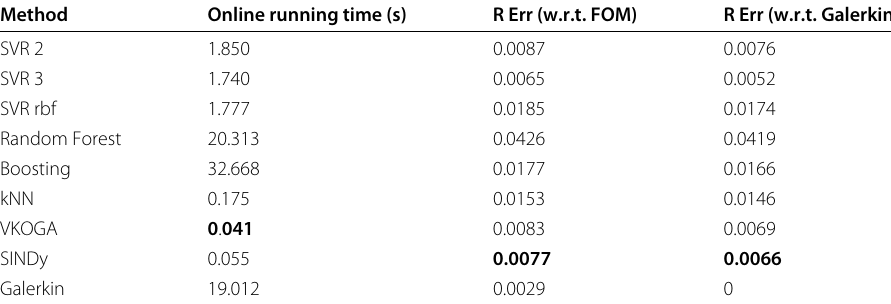
Table 4 Comparison of different machine learning methods using 4th-order Runge–Kutta for 2D convection–diffusion